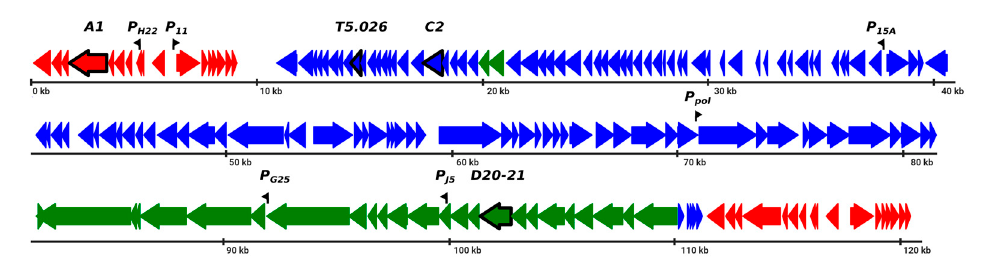
Figure 1. Scheme of the phage T5 genome. Phage genes are shown as colored arrows whose directions match the direction of transcription: red = pre-early genes (located in “first step of transfer” (FST)-DNA in the left upper part of the figure), blue = early, green = late genes. The FST-DNA is duplicated form terminal repeats of the genome. Genes and promoters described in this study are highlighted.